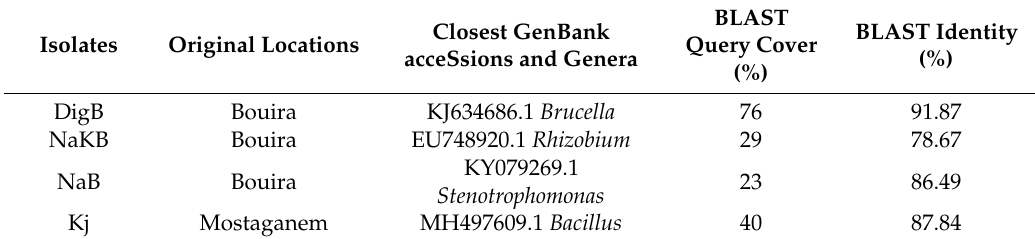
Table 3. Bacterial isolates found in the cysts of Globodera rostochiensis from Algeria, and the